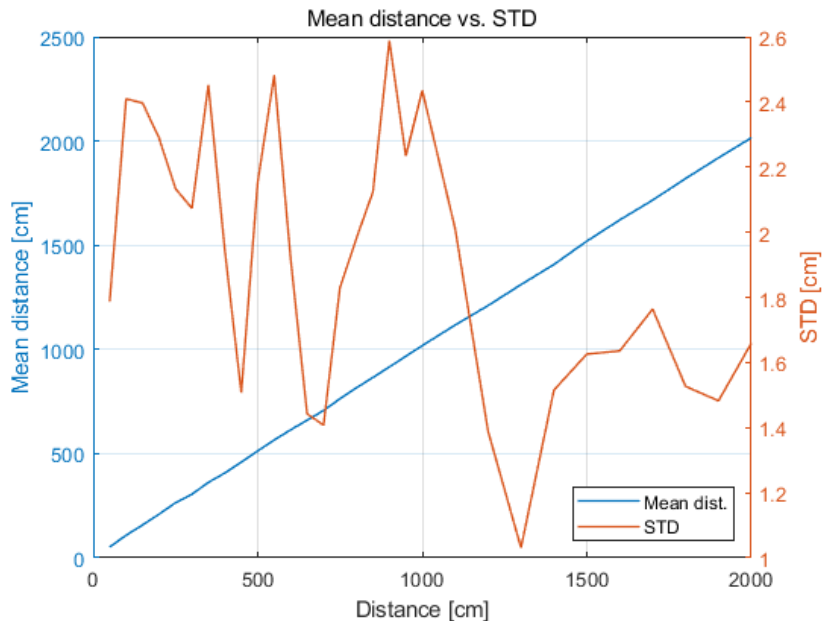
Figure 5. Change in standard deviation with distance. With the reference value (which was determined using a laser rangefinder and a tape measure), it is possible to establish the examined UWB system’s accuracy. The essential statistical measurements of errors are summarised in Table 3. Table 3. Statistical measures of the accuracy (distance error) under LOS conditions.